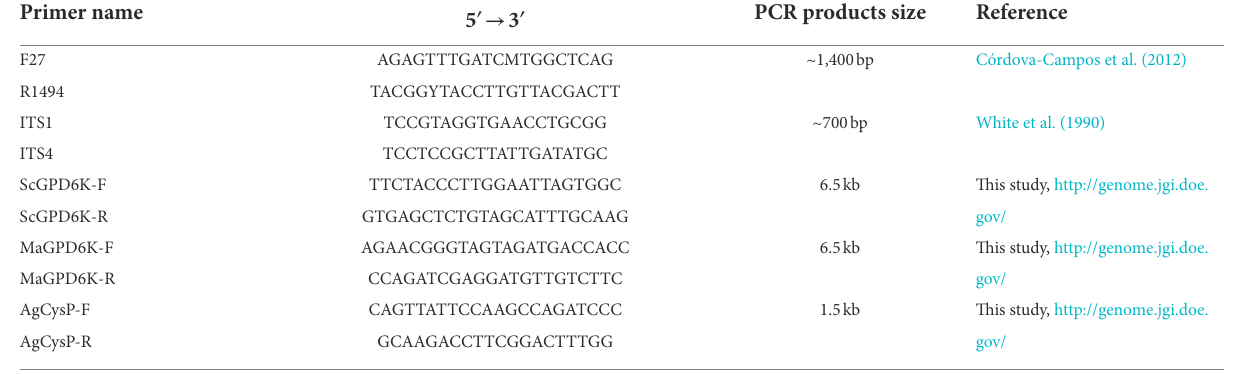
TABLE 2 Primers used in this